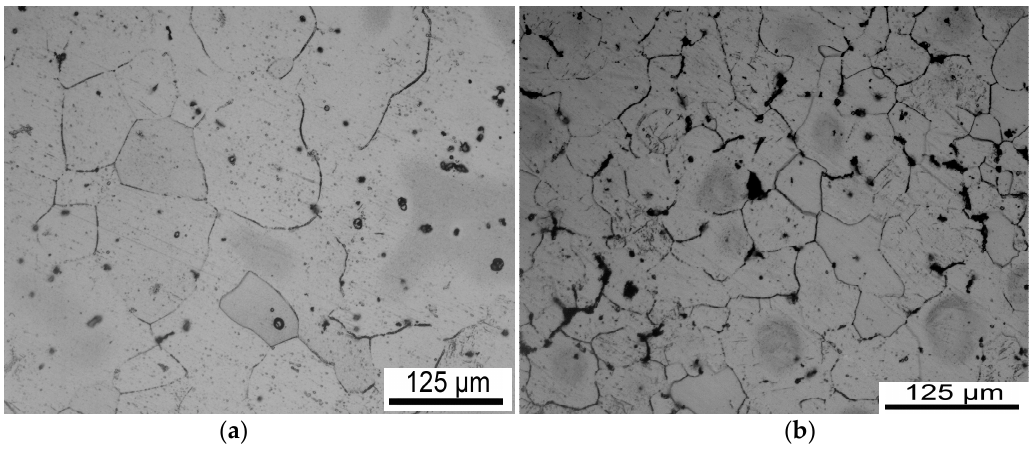
Figure 1. OM images of as-cast ( a ) AZ91 alloy ( b ) nano-SiCp/AZ91 composite.